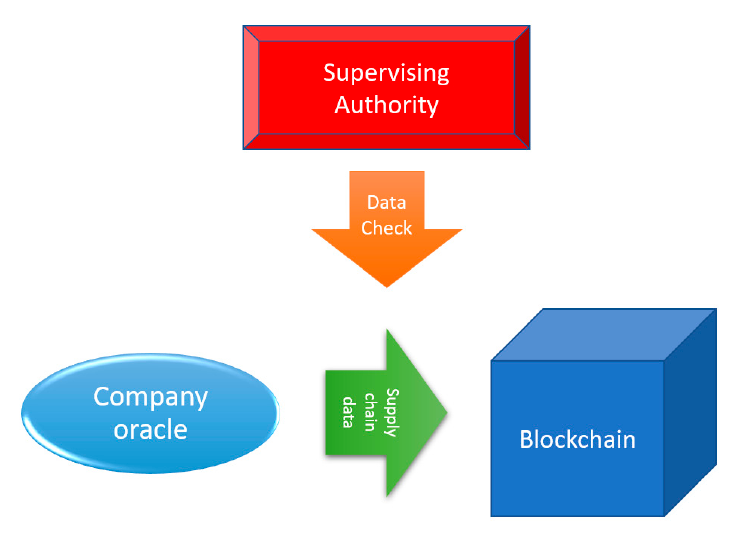
Figure 5. Example of a trust model [22].